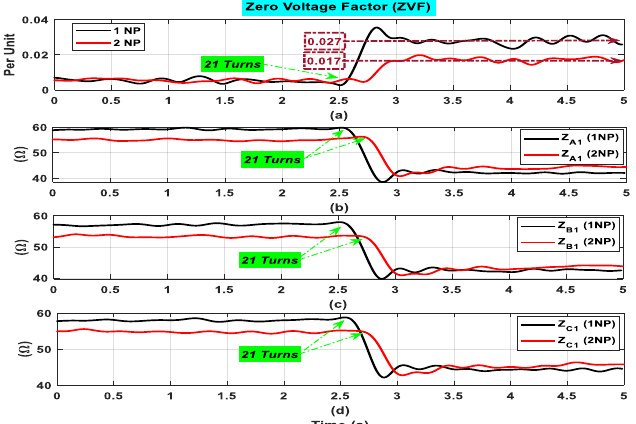
Figure 14. ZVF indicator and estimated impedances, assessed for the healthy state and in the presence of 21 shorted turns, phase a1, for the two topologies (1NP and 2NP). (a) ZVF; (b) Z A1 ; (c) Z B1 ; (d) Z C1 . Table 3. ZVF values for two different stator topologies with 21 shorted